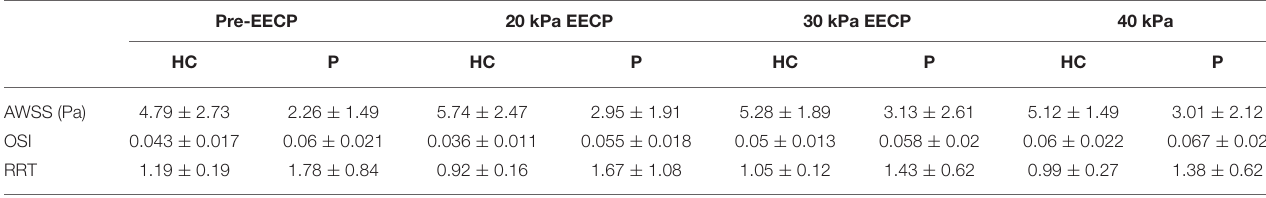
TABLE 1 | Variations in wall shear stress (WSS)-derived hemodynamic factors before and during enhanced external counterpulsation (EECP). Pre-EECP 20 kPa EECP 30 kPa EECP 40 kPa HC AWSS